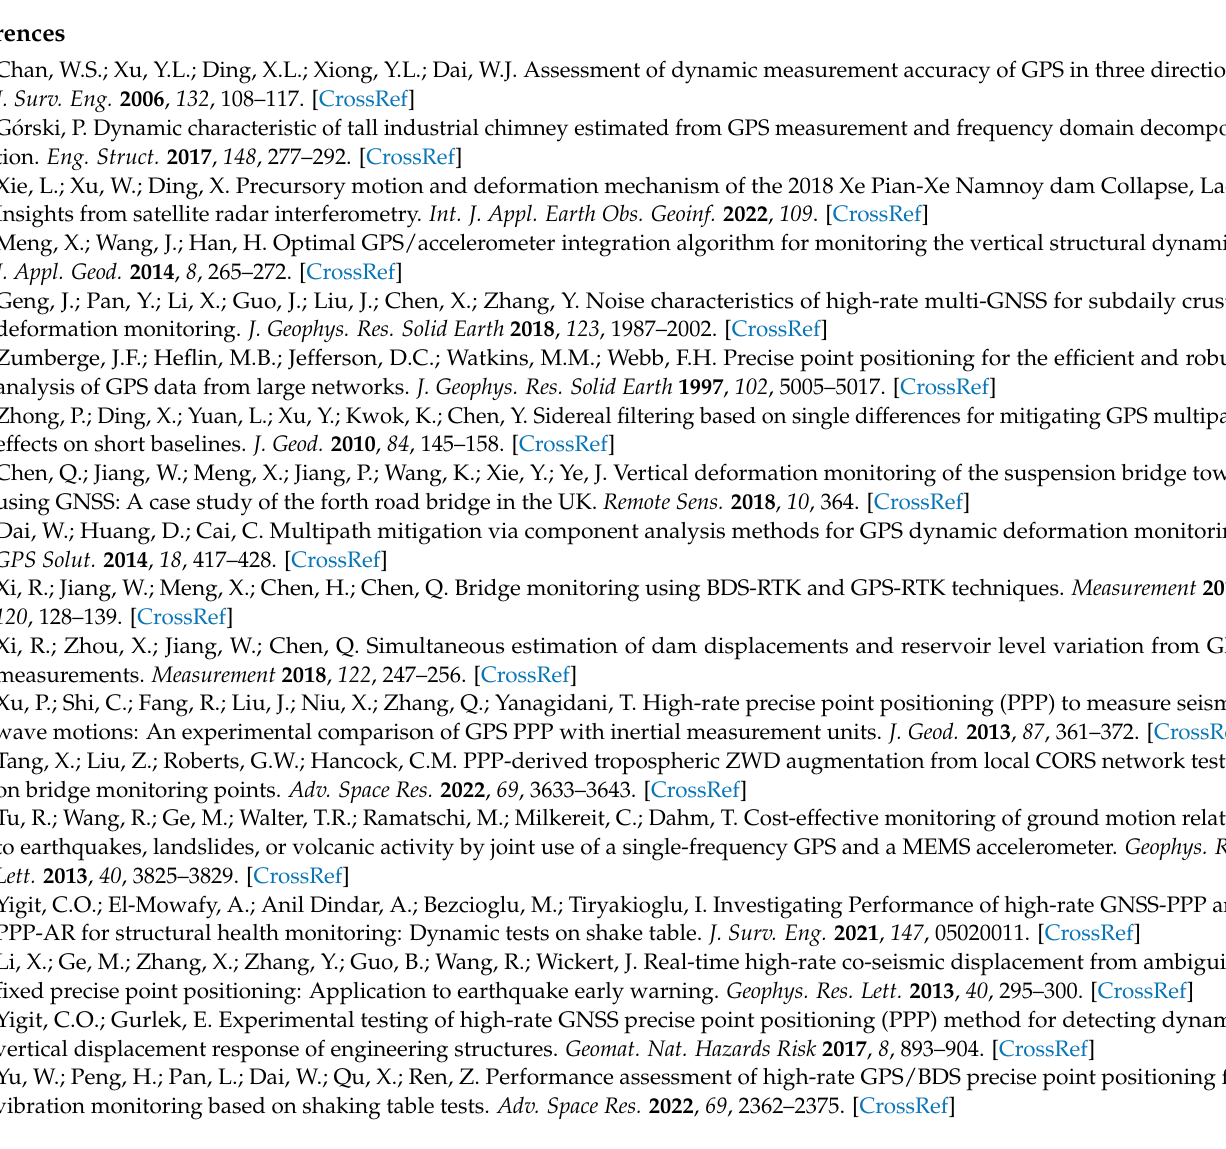
Figure A5. Comparison between 100-Hz, 10-Hz and 1-Hz GNSS time series (red dots) and laser displacement transducer (yellow dots) for the second sinusoidal